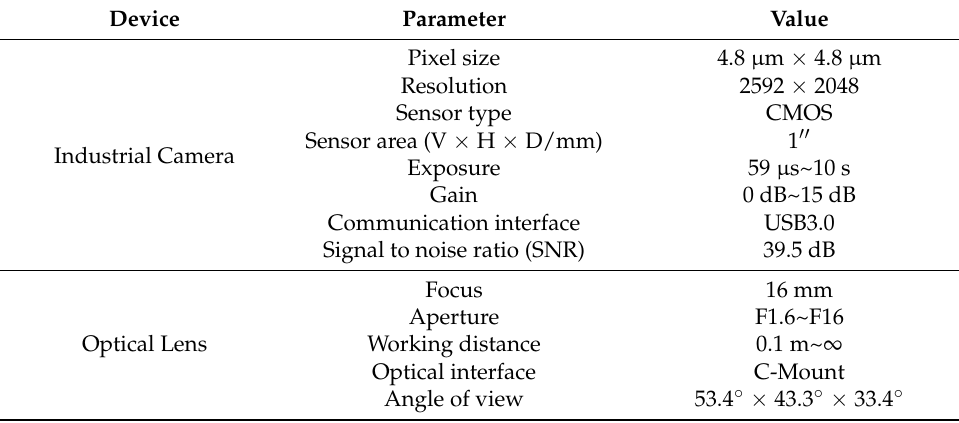
Figure 4. The response curve of the industrial camera sensor. Table 1. Performance parameters of the industrial camera.